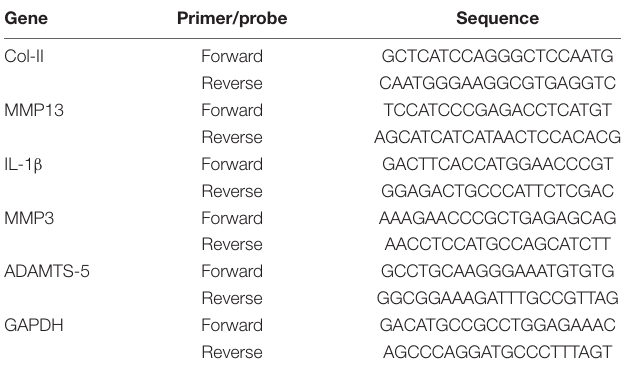
TABLE 1 | Primers used for